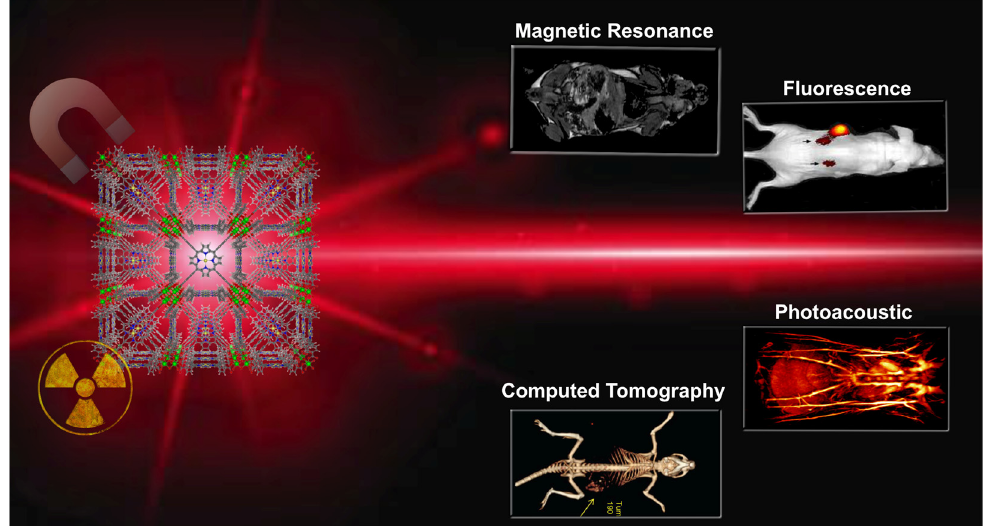
Figure 3. Schematic illustration of cancer imaging techniques used with porphyrin NMOFs.